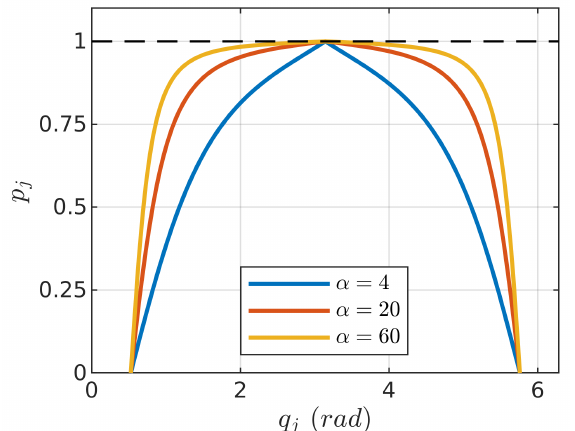
Figure 5. Penalization factor as a function of a generic j -th joint. For this case, q j , min = 0.5 rad, q j , max = 5.8